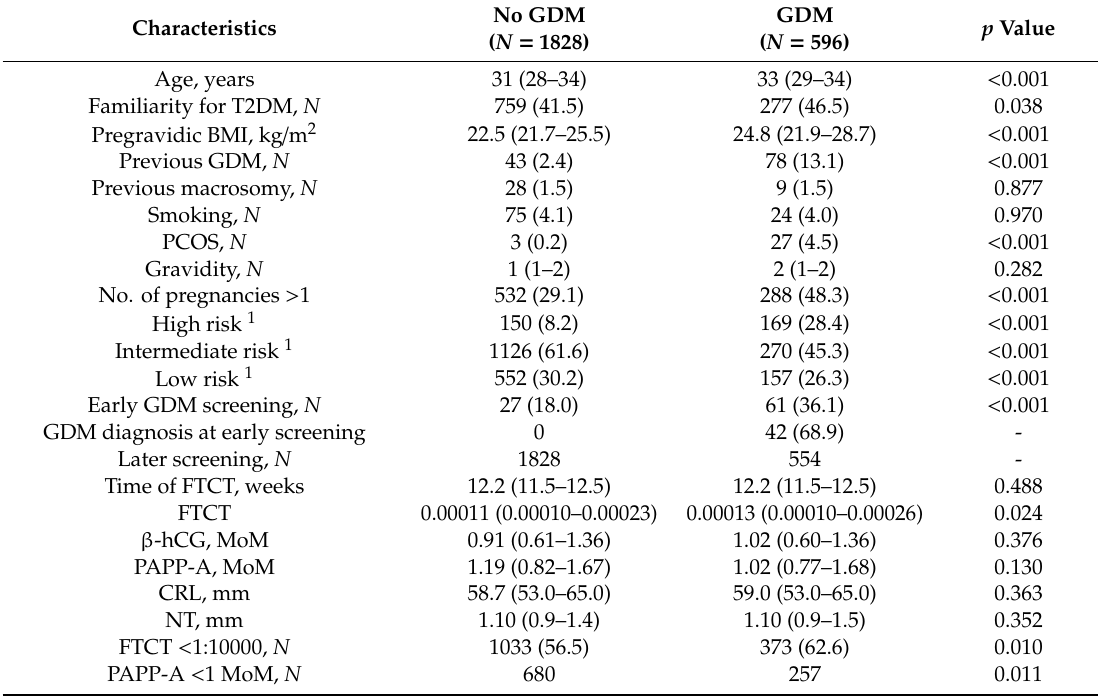
Data are medians (interquartile range) or N (%). p Values refer to overall di ff erences across groups as derived from the non-parametric Mann–Whitney test or Fisher’s exact test, respectively. T2DM: Type 2 diabetes mellitus; PCOS: polycystic ovary syndrome; FTCT: first trimester combined test; β -hCG: β -human chorionic gonadotropin; PAPP-A: pregnancy-associated plasma protein A; CRL: crown rump length; NT: nuchal translucency. 1 According to the Italian guidelines [23], high-risk women are those with at least one of the following parameters: Previous GDM, pre-pregnancy body mass index (BMI) ≥ 30 kg / m 2 , or fasting plasma glucose (FPG) at first trimester or before pregnancy between 100–125 mg / dL (5.6–6.9 mmol / L). For these women, early GDM screening at 16–18 weeks of gestation is